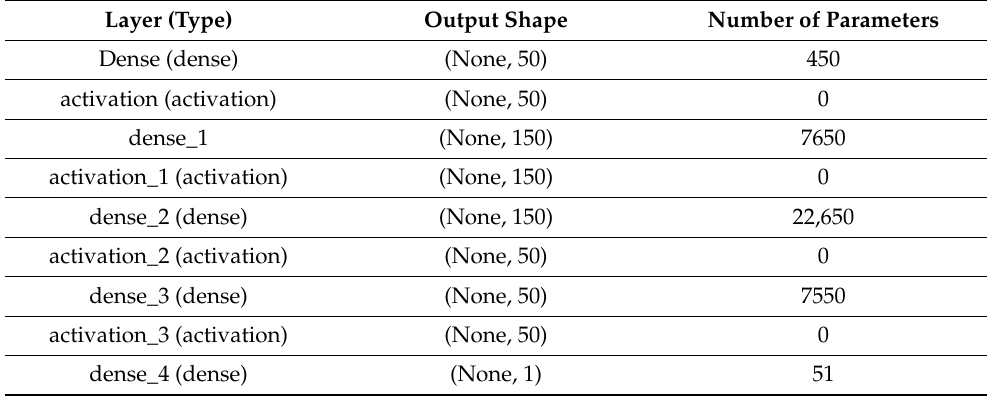
Table 4. ANN model summary.